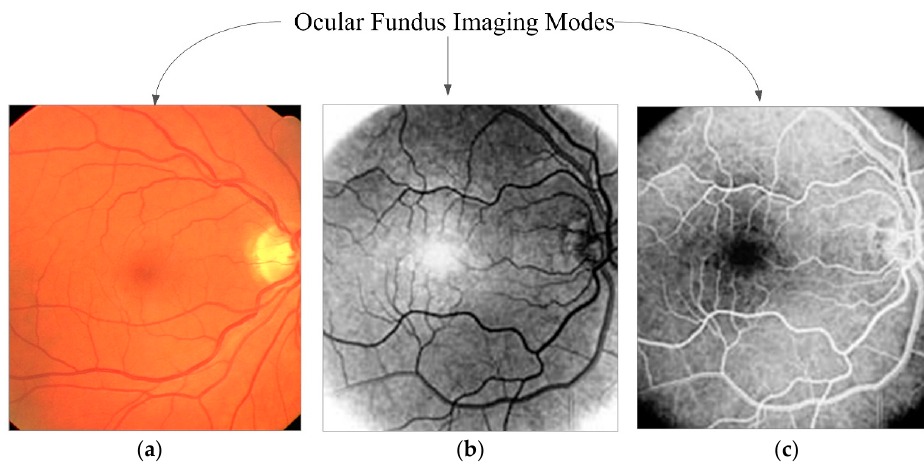
Figure 3. Imaging modes of ocular fundus photography: ( a ) full color retinal fundus image; ( b ) monochromatic (filtered) retinal fundus image; and ( c ) fluorescence angiogram retinal fundus image.